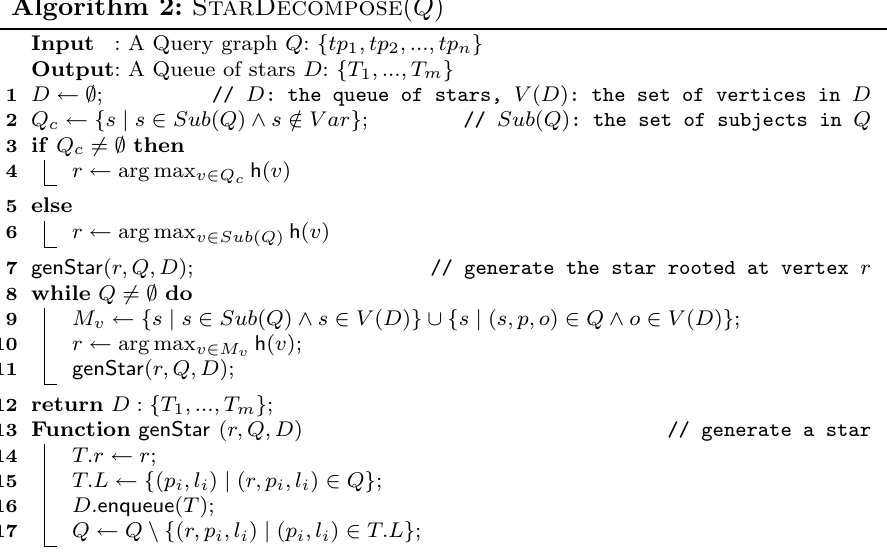
Algorithm 2: StarDecompose ( Q